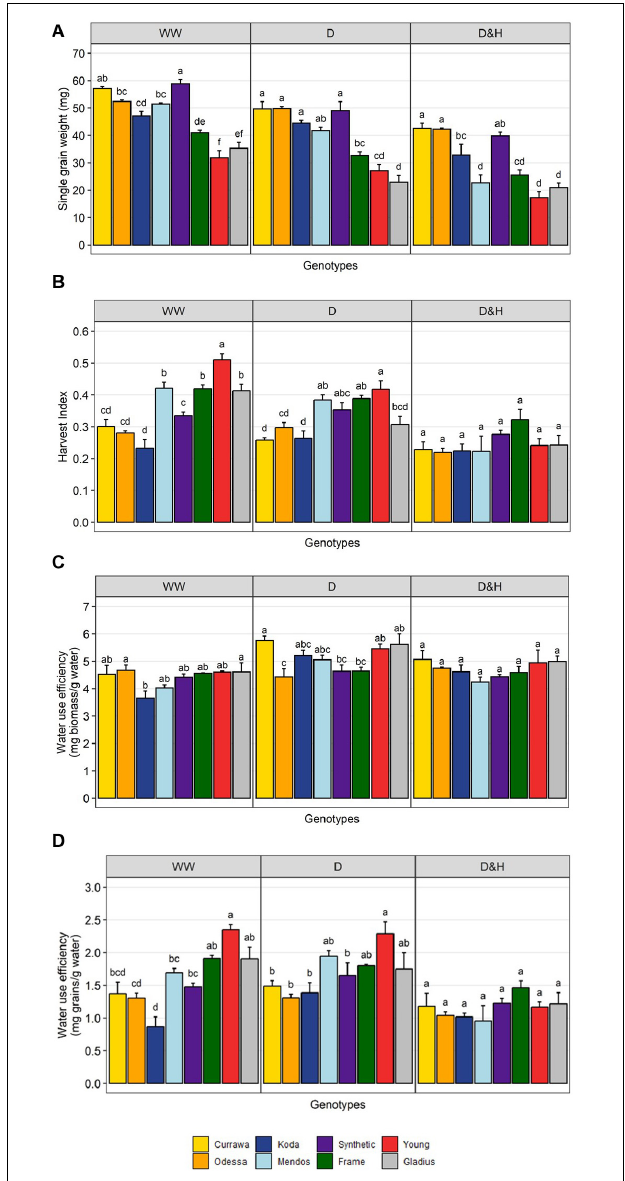
FIGURE 4 | Reduction in yield per plant was due to reduction in grain weight post-anthesis. Genotypic differences in single grain weight (A) , harvest index (B) , biomass water-use efficiency (C) , and grain water-use efficiency (D) . Plants grown in well-watered conditions (WW), drought (D), or combined drought and heat stress (D&H). Values are means and standard error of four replicates ( n = 4). Values represent average per plant. Data were subjected to two-way ANOVA. Letters indicate the results of Tukey’s test comparing genotype effect within each treatment ( p <